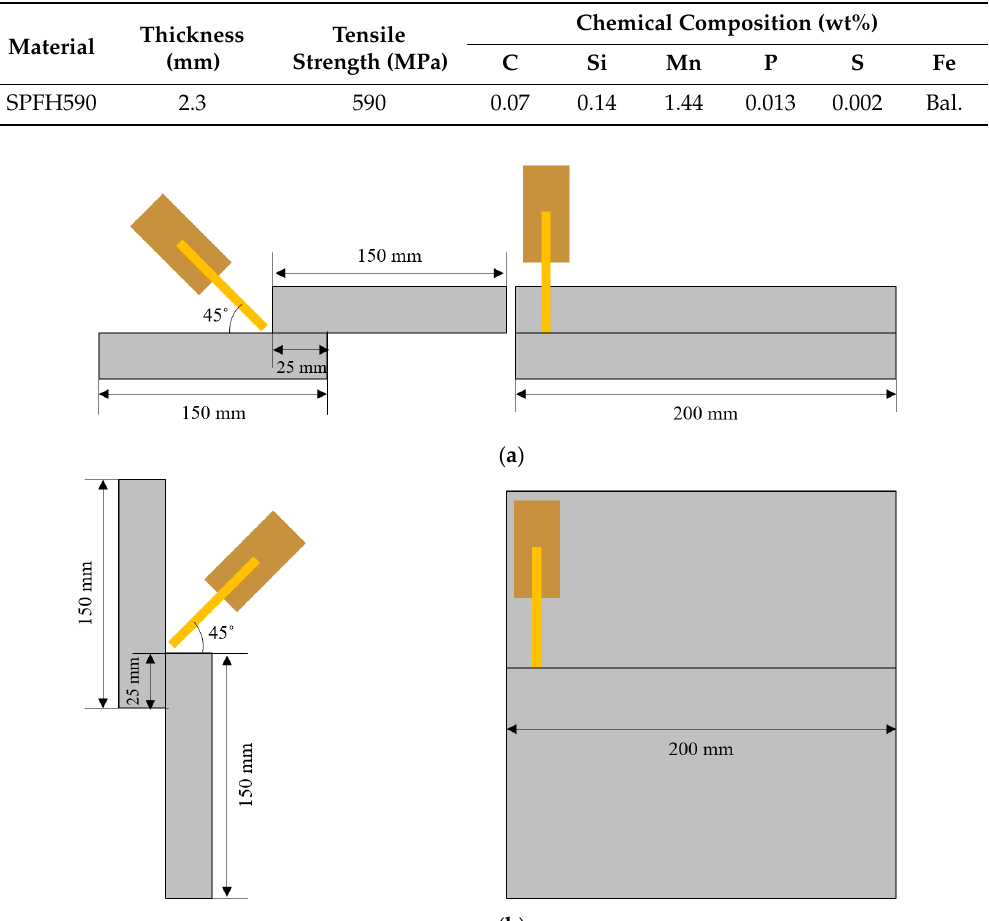
Table 1. Specification of the test material.